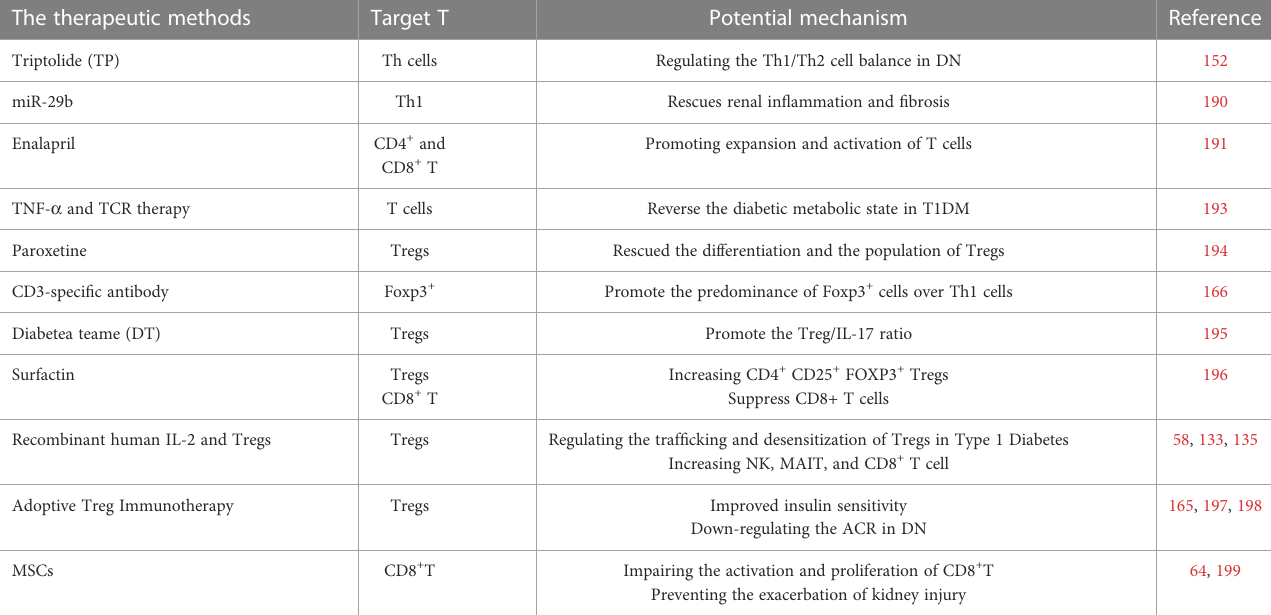
TABLE 1 The therapeutic methods targeting to T cells in